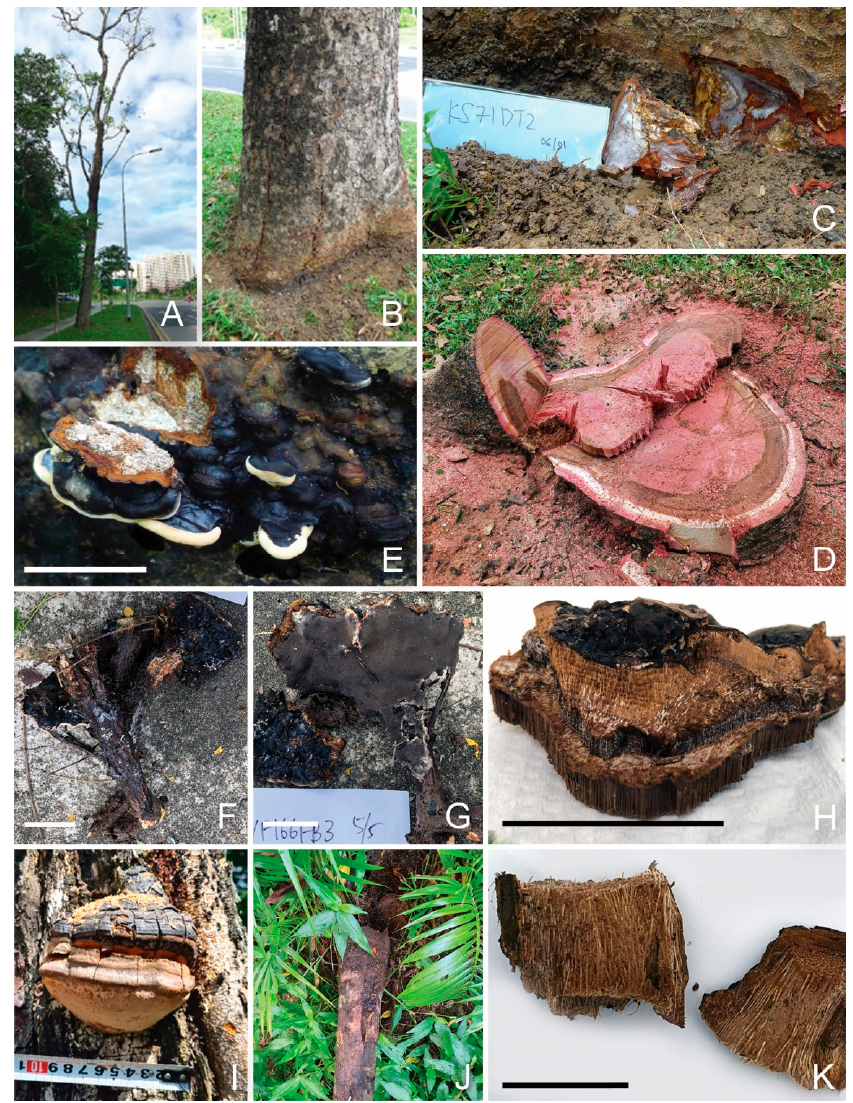
Figure 4. Phellinus species detected in Singapore urban trees. ( A ): A diseased Khaya tree (KS71); ( B ): a black ring near trunk base of the Khaya tree (KS71); ( C ): bark area (KS71DT2) with P. noxius mycelia; ( D ): KS71 tree stump with a ring of decayed wood infected by P. noxius ; ( E ): a mosaic fruiting body of three P. noxius strains on a log of unknown species (L129); ( F , G ): a P. noxius fruiting body attached to a fallen branch near a Yellow Flame tree (YF166, pileus surface and pore surface); ( H ): cross-section of YF166FB3; ( I ): a P. pachyphloeus fruiting body on a Yellow Flame tree trunk (YF126FB); ( J ): a Yellow Cane Palm with basal decay (P171); ( K ): the Yellow Cane Palm stem, decayed by P. noxius and Ganoderma species (P171DT). Bar = 5 cm.